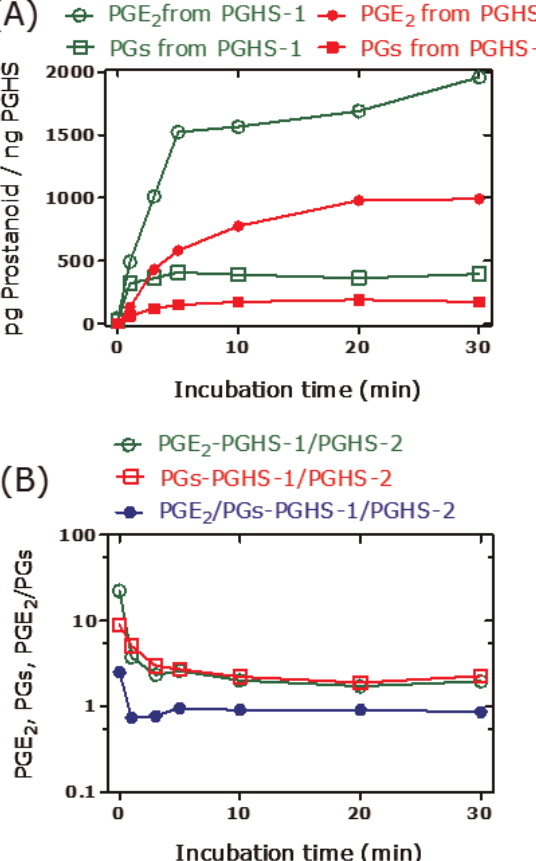
Figure 4. Molar ratio of the prostanoid 15-keto-PGF 2 α or 9ß,11 α -PGF 2 α to PGF 2 α in incubation mixtures of arachidonic acid (10 µM) and (a) recombinant PGHS-1 (5 U) or (b) recom- binant PGHS-2 (5 U) in the absence or in the presence (indi- cated by the symbol +) of N -acetyl-L-cysteine (100 µM) at 37°C for the indicated time points. Experimental conditions and prostanoids analysis were as described elsewhere